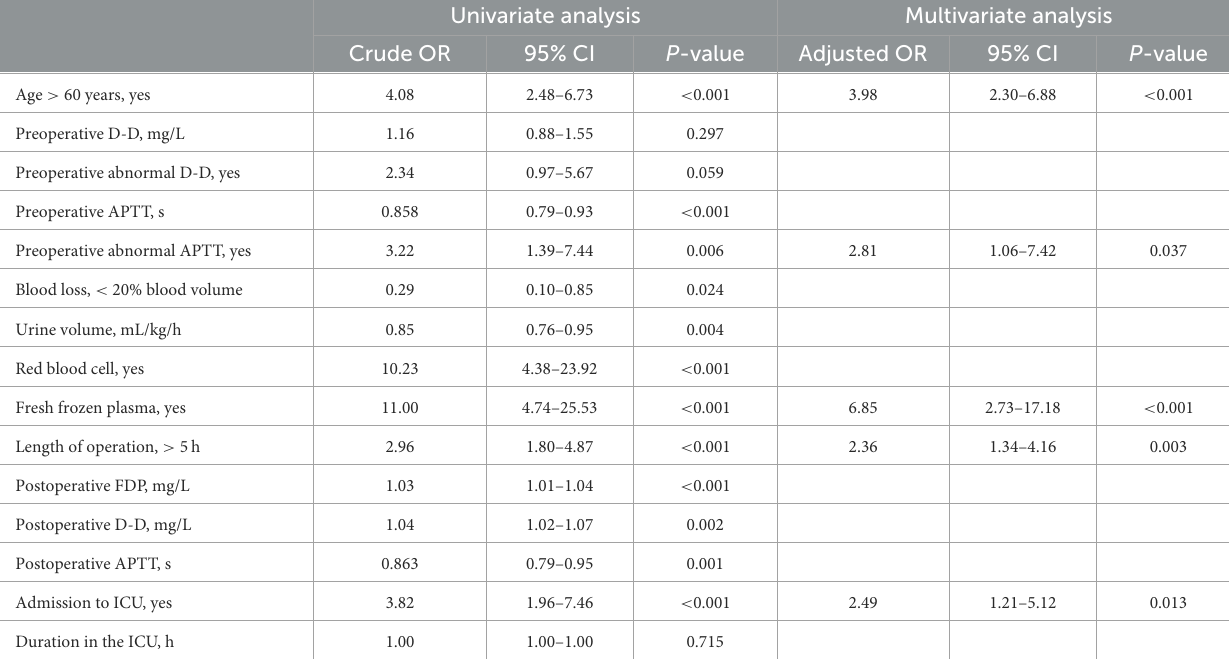
TABLE 3 Univariate and multivariate analyses for deep venous thrombosis. Univariate analysis Multivariate